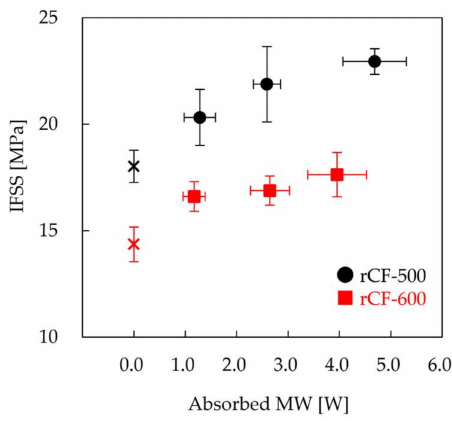
Figure 5. IFSSs of MW-irradiated samples prepared with rCF-500 (black symbol) and rCF-600 (red symbol) as a function of absorbed MW.